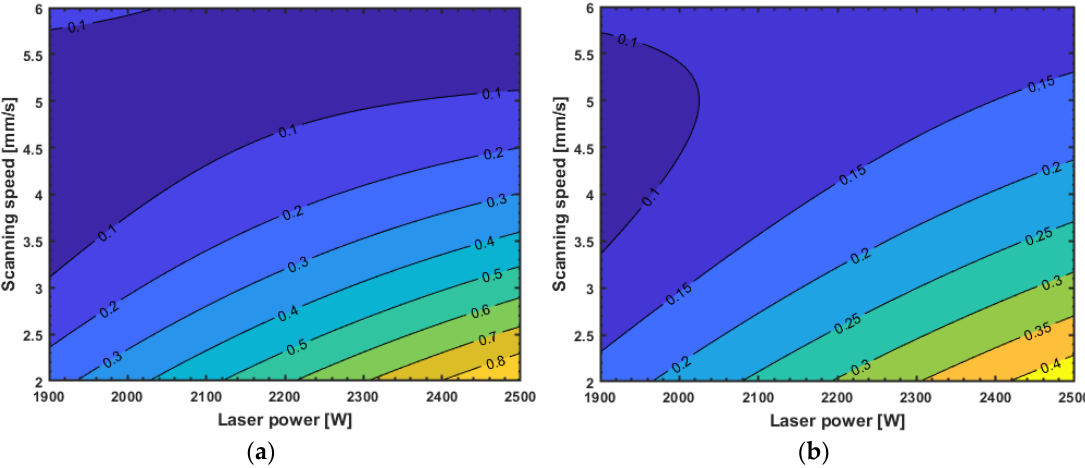
Figure 9. Contour plot of case depth [mm] versus power, scanning speed, and rotation speed (1875 rpm) for the flank tilt angle of 20°: ( a ) at the tip of splines’ tooth (H T ), ( b ) at the root of splines’ tooth (H R ).